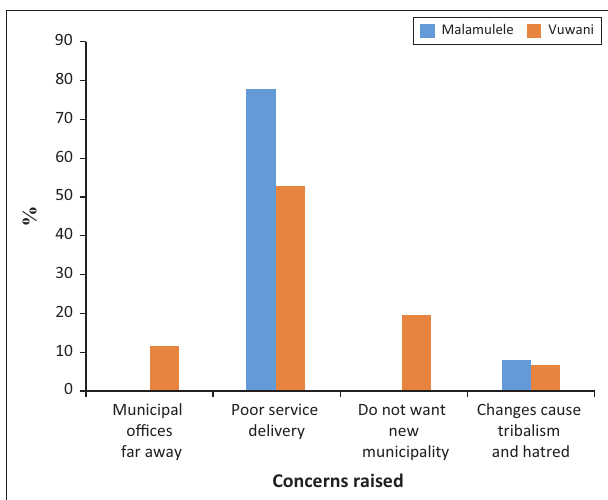
FIGURE 4: Main concerns raised by participants regarding changes of municipal